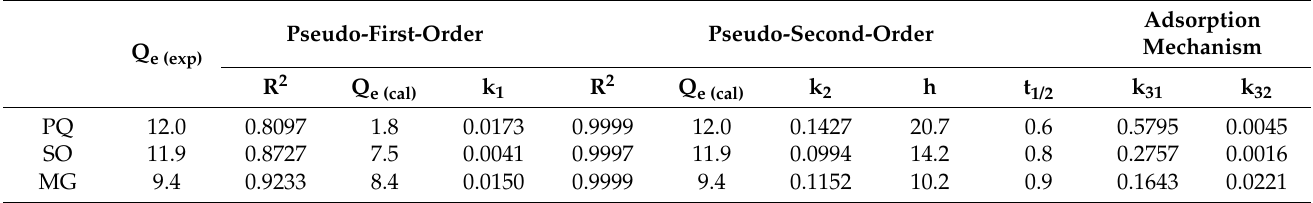
Table 2. Pseudo-second-order and pseudo-first-order kinetics parameters (conditions: 2 g/L of adsorbent dosage, 25 mg/L of initial concentration, optimal pH, and temperature at 303